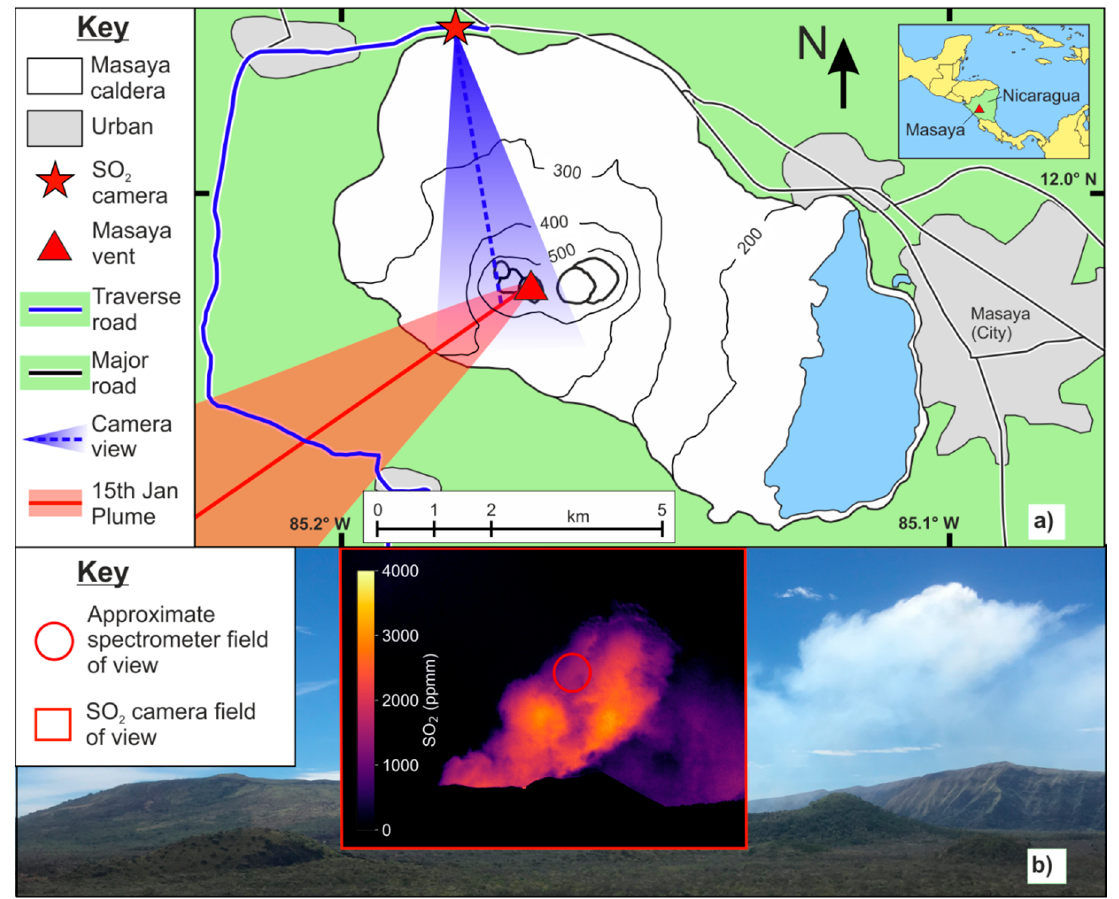
Figure 1. After [43]. ( a ) A map of Masaya volcano showing key measurement locations, the active vent and the approximate location of the gas plume. The inset shows the location of Masaya volcano within Nicaragua; ( b ) a photo of Masaya volcano showing the measurement conditions on the 15th January, captured at 11:27 local time, with the approximate field of view of the spectrometer (circle) and camera (red square) marked. The closest SO 2 camera image for the time of the photo is shown in the field of view box.